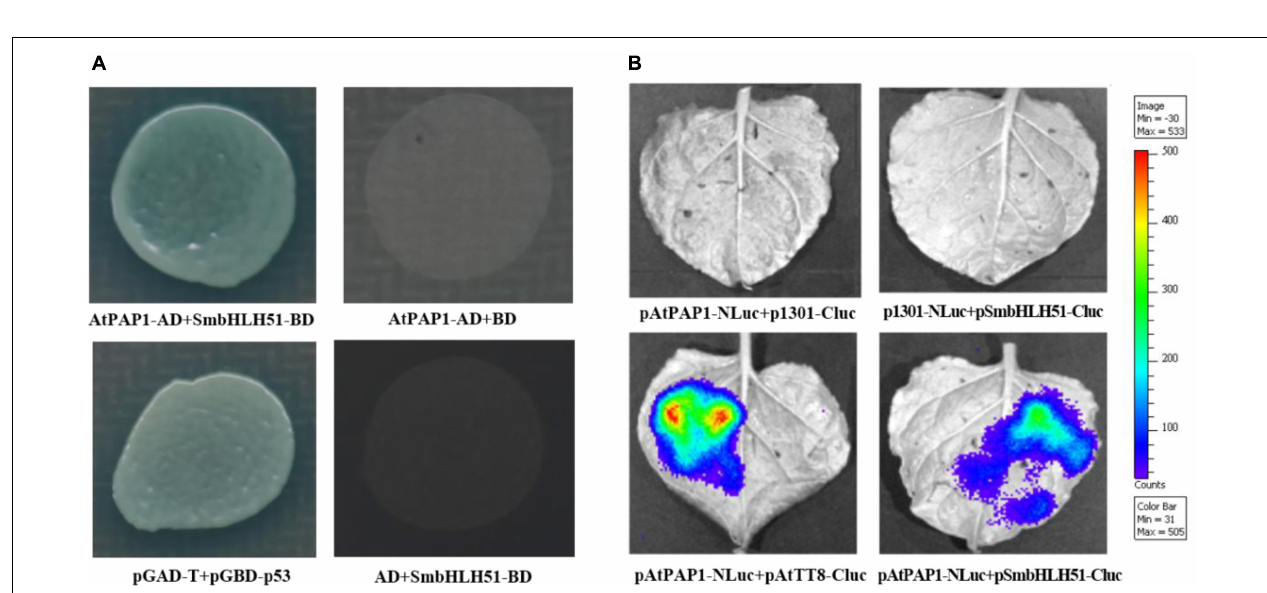
FIGURE 4 | AtPAP1 physically interacts with SmbHLH51. (A) Y2H assay to test interactions of AtPAP1 with SmbHLH51. AtPAP1 was fused with activation domain while SmbHLH51 was fused with DNA-binding domain. (B) LCI assay to detect interactions of AtPAP1 with SmbHLH51. AtPAP1was fused with N-terminal of luciferase to produce pAtPAP1-NLuc. AtTT8 (GenBank Accession Number NM_117050) and SmbHLH51 were fused with C-terminal of luciferase to produce pAtTT8-Cluc and pSmbHLH51-Cluc, respectively.